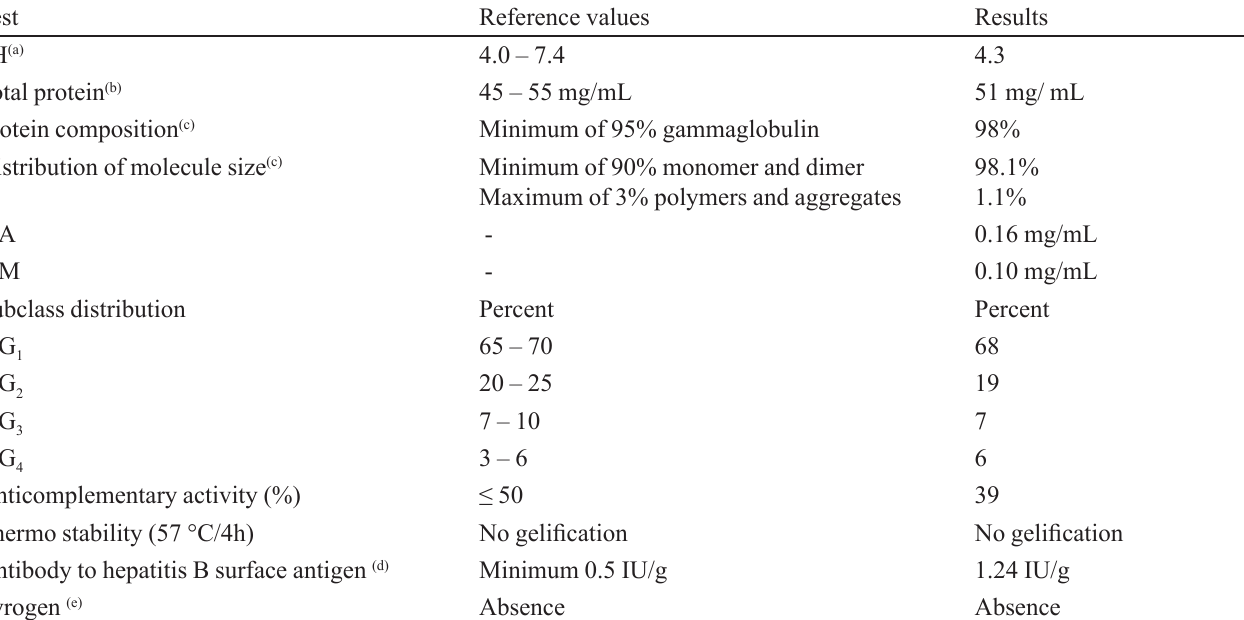
TABLE I – Anti-dengue IgG characterization